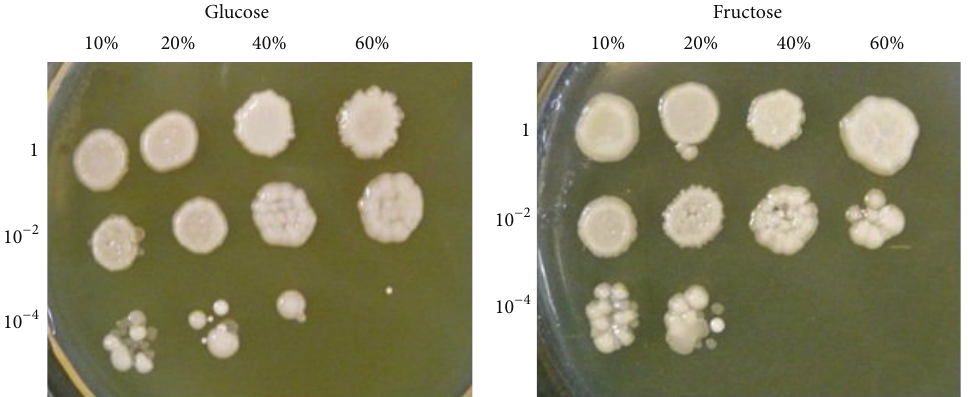
Figure 6: Cell viability assay of S. cerevisiae YPH250 cells after exposure to high concentrations of glucose and fructose. In all samples within each plate, cell concentration was equaled and successively diluted by a factor of 100 down to 10 −4 . Representative results from a set of three experiments are